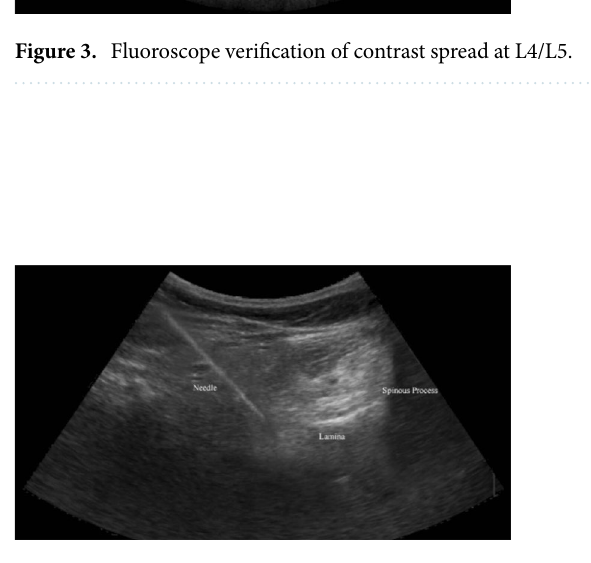
Figure 4. Ultrasound view of needle placement at